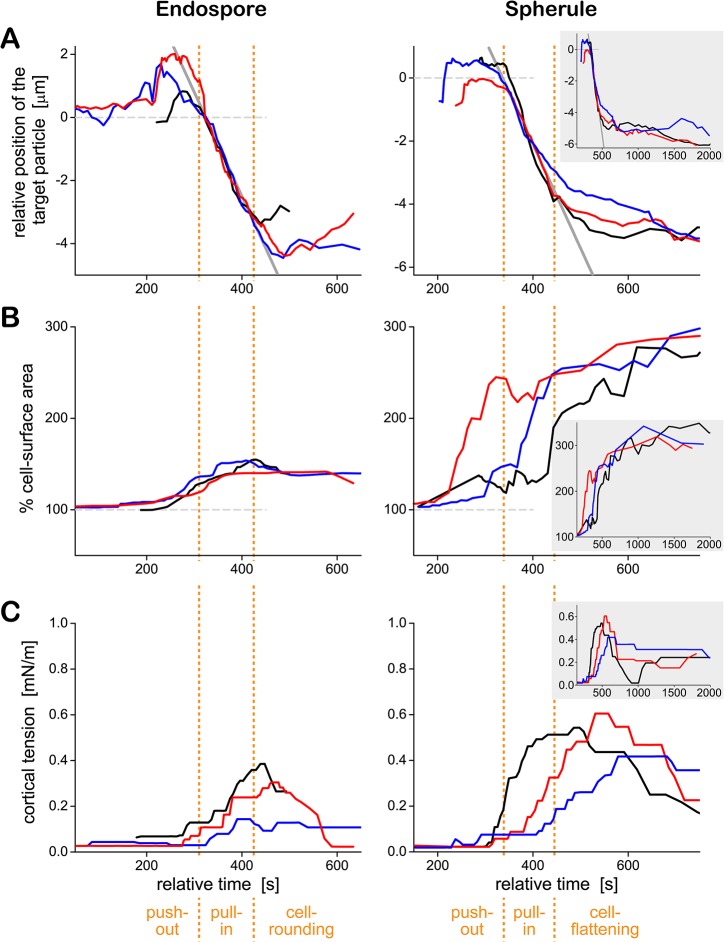
Quantitative analysis of the time course of phagocytosis of C. posadasii endospores (left) and spherules (right) by human neutrophils.Representative timelines of the target position (aligned for best overlap of the trajectories during the pull-in phase) (A), the cell-surface area (B), and the cortical tension (C) are shown for three particles of each type. For each target type, a given color indicates the same cell-target pair throughout parts A, B, and C. The three phases identified at the bottom of the figure were determined by inspection of the time-dependent neutrophil morphologies in the recorded image sequences. Positive values of the target position shown in part A reflect a push-out of the particle. A monotonous decrease of the position values characterizes the pull-in phase. The end of the pull-in phase marks the start of the final phase. The inset in the right panels depicts the cell behavior over an extended period of time (~33 minutes). Common axis titles are shown only once at the left and bottom of the figure.